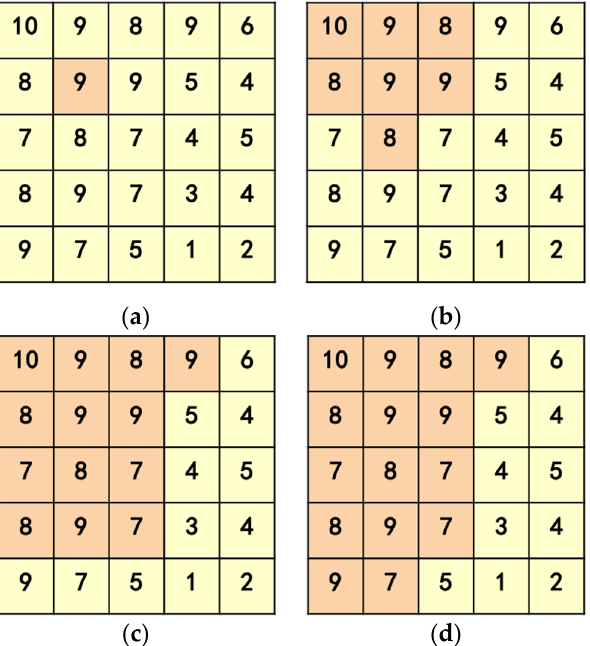
Figure 6. The different stages of region growing algorithm. ( a ) Initial growth points; ( b ) first eight directional growth; ( c ) second eight directional growth; ( d ) meet termination conditions.